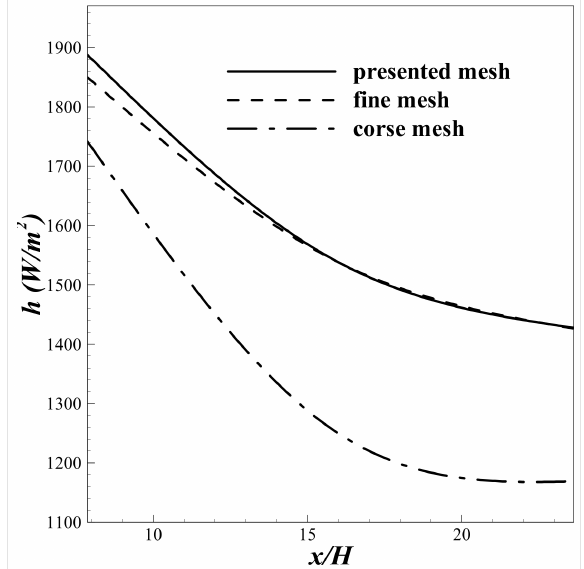
Figure 4. The study of grid independency for the presented solution considering three different unstructured grids with 63,432 (fine), 27,491 (average), and 5502 (coarse) nodes.